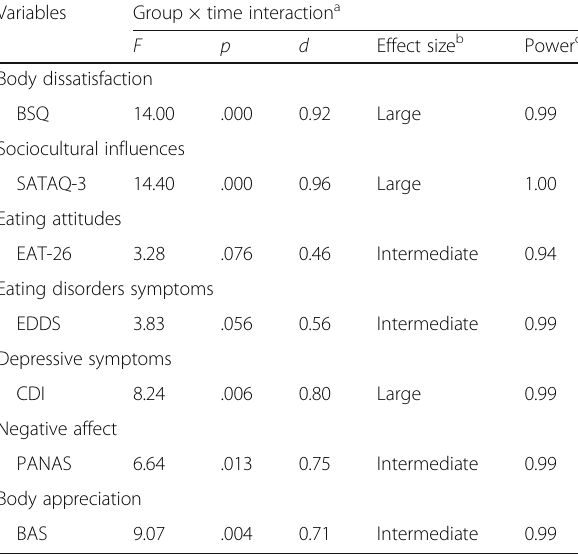
Table 3 Group × time interactions on the outcomes variables and effect sizes (Cohen ’ s d